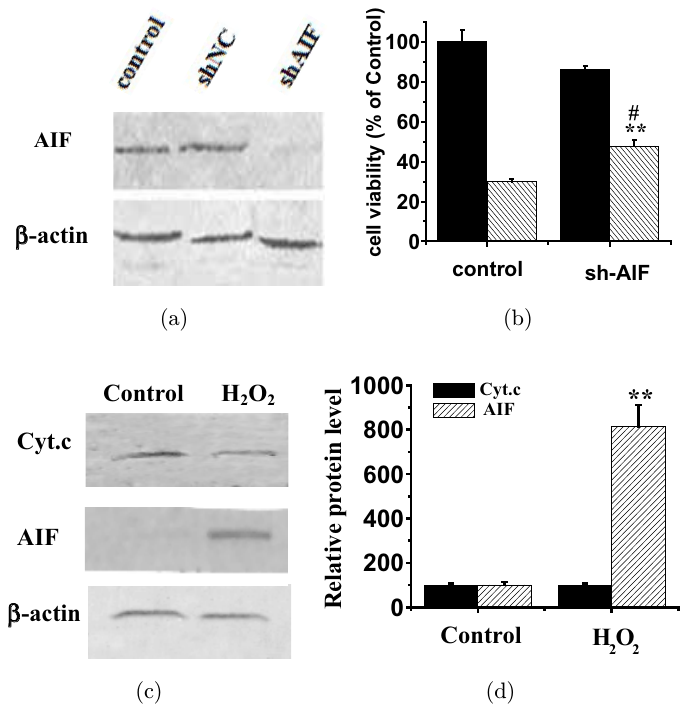
Fig. 4. AIF plays an important role in H 2 O 2 -induced apoptosis. (a) The e®ect of silencing AIF (shAIF) veri¯ed by Western blotting analysis. (b) Silencing AIF largely attenuated H 2 O 2 -induced cell death assessed by CCK-8 assay. The shAIF was used as a negative control. Data are mean (cid:4) SD ( n ¼ 3; ANOVA: ** p < 0 : 01, compared with control cells, # p < 0 : 01, compared with H 2 O 2 treatment alone cells). (c) H 2 O 2 induced the up-regulation expression levels of AIF but not Cyt.c by Western blotting analysis. (cid:1) -actin served as the loading control. (d) Quantitative analysis of Cyt.c and AIF expression levels. Data are mean (cid:4) SD ( n ¼ 3; ANOVA: ** p < 0 : 01, compared with control